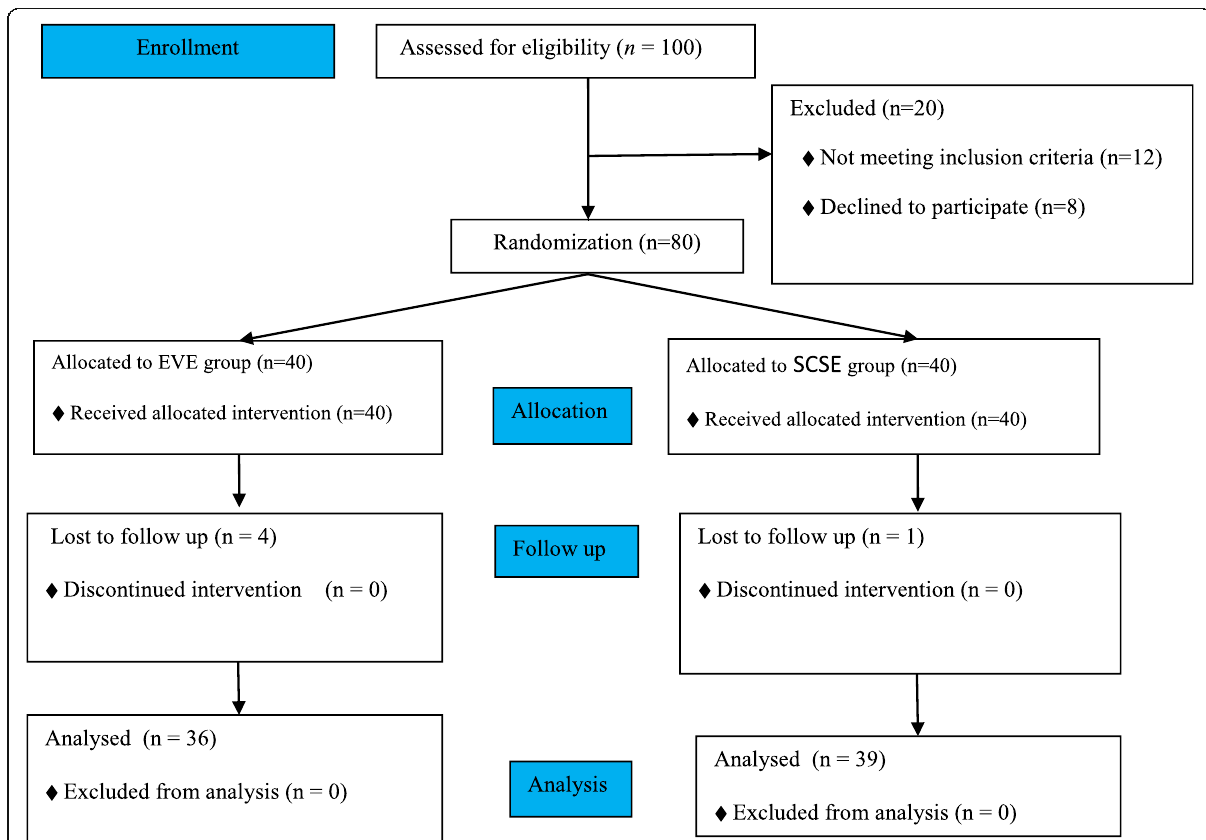
Fig. 1 Flowchart in the study. EVE epidural volume extension, SCSE sequential combined spinal epidural